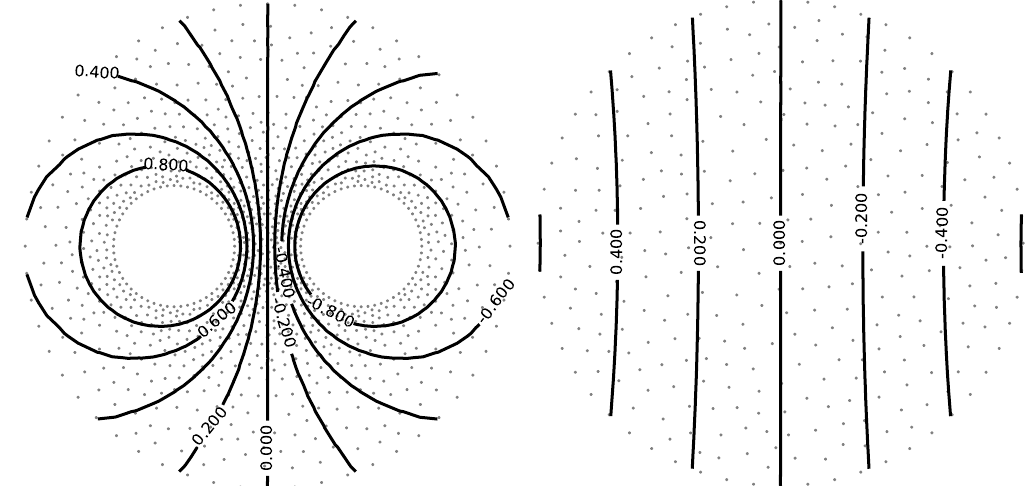
Figure 5. Numerical solutions for Φ on inner ( left ) and outer ( right ) meshes as equipotential lines.